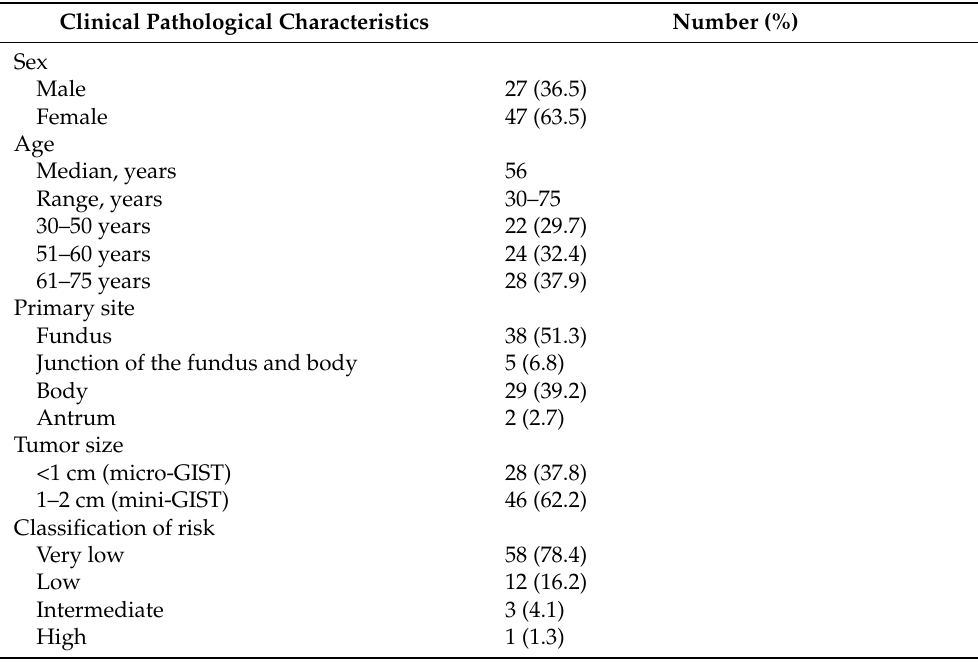
Table 2. Clinicopathological characteristics of 74 patients with small gastrointestinal stromal